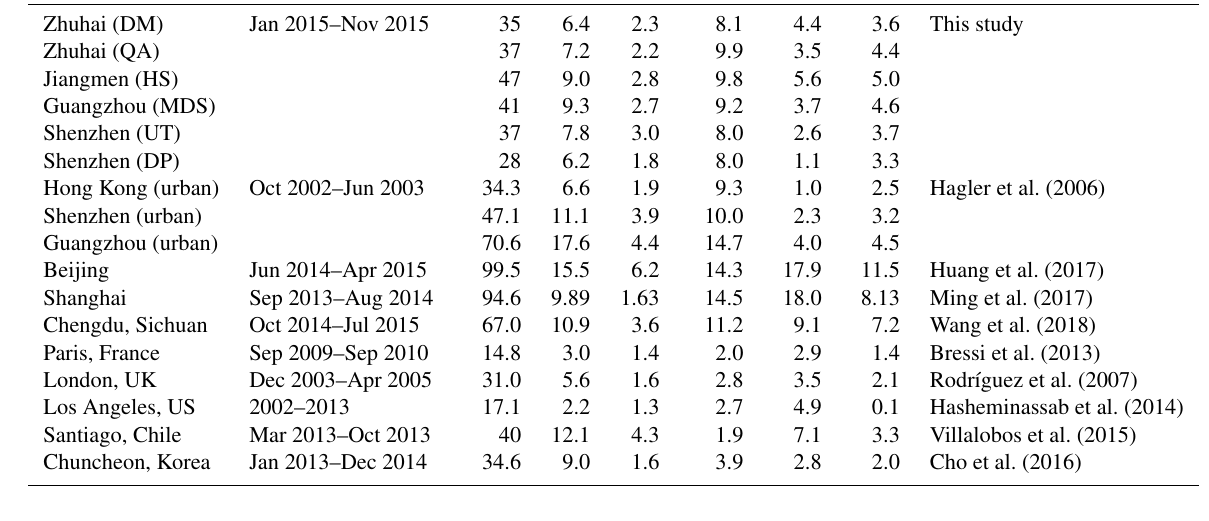
Table 5. The comparison of the major chemical compositions of PM 2 . 5 in typical cities (unit: µgm − 3 ). Cities